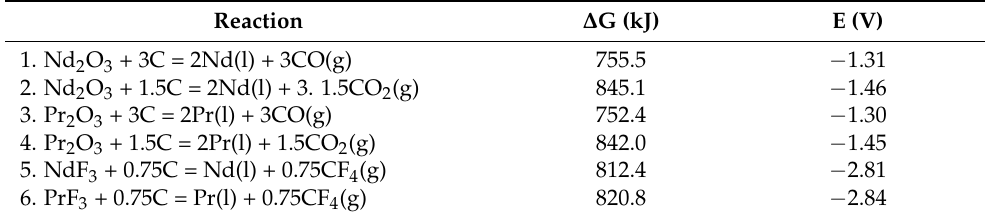
Table 1. Main cell reactions and their reversible potentials at 1040 ◦ C. Data from HSC Chemistry v. 10.0.3.9